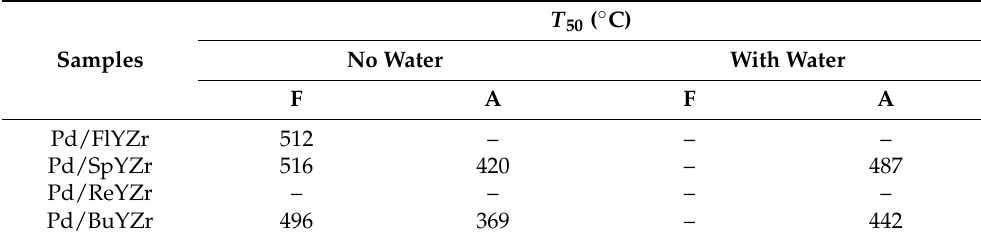
Figure 9. CH 4 conversion curves of fresh ( a ) and aged ( b ) Pd/Y-ZrO 2 catalyst with different morphologies. Table 4. The characteristic temperature of CH 4 oxidation reaction of Pd/Y-ZrO 2 catalysts with different